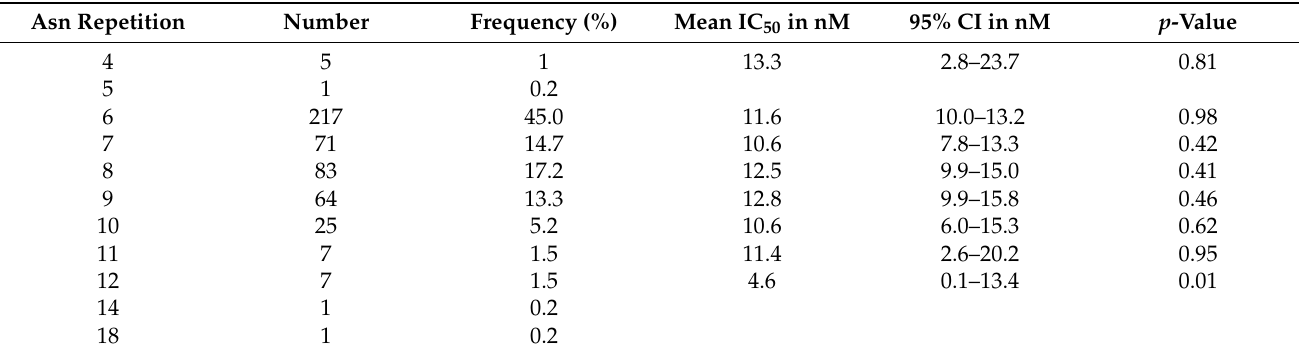
Table 5. Association between Pfmdr6 Asn repeats among 482 clinical P. falciparum African isolates and ex vivo susceptibility to methylene